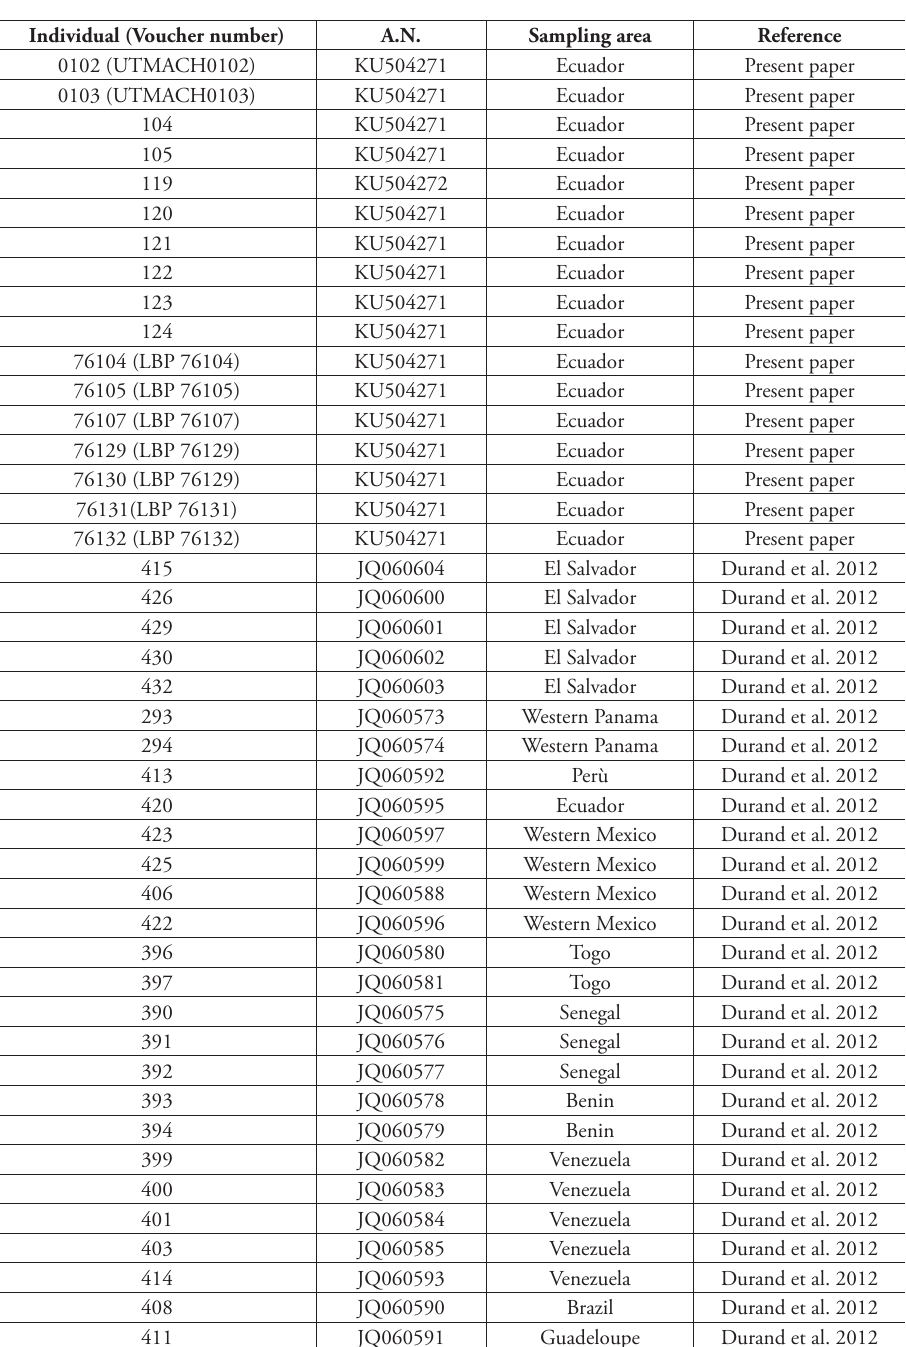
Table 1. GenBank accession number (A.N.), sampling areas and references of the Mugil sp. COI sequen- ces used in phylogenetic